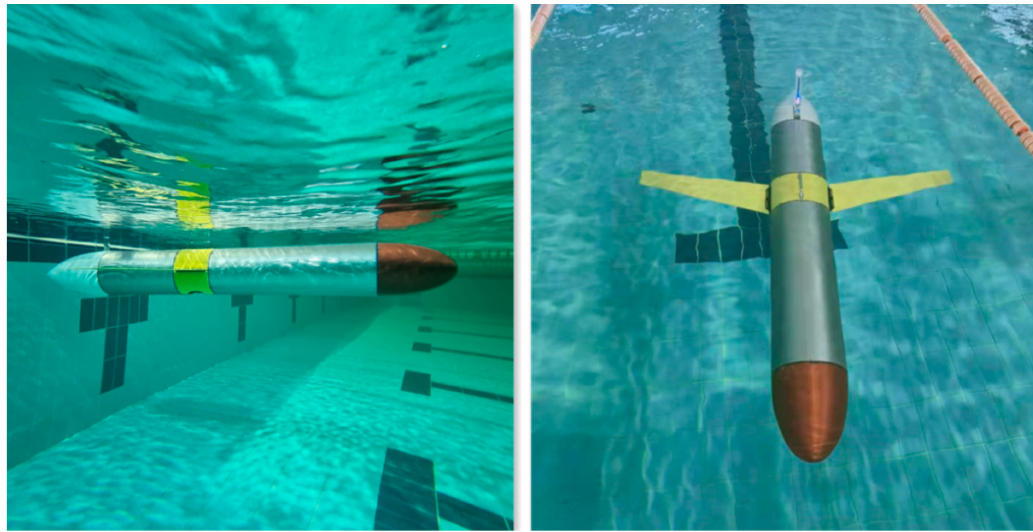
Figure 15. Photographs of the experimental site.